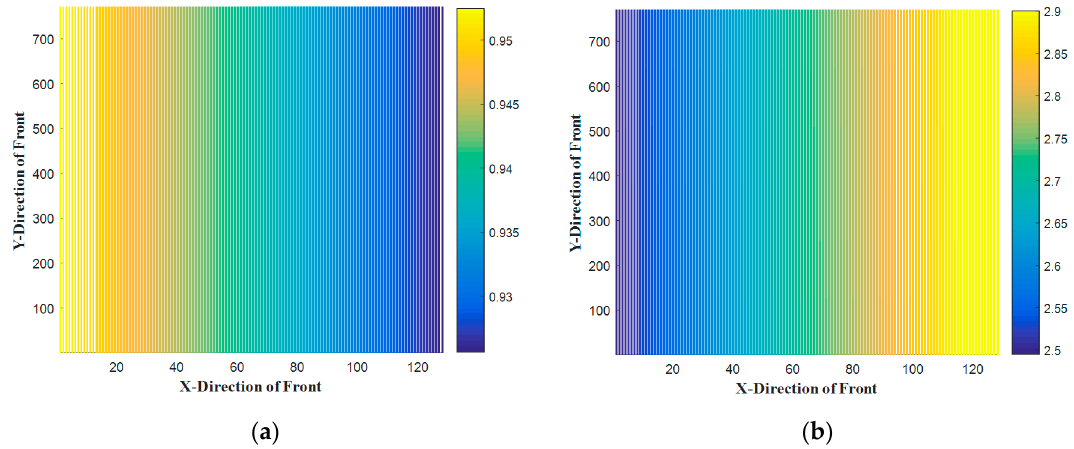
Figure 12. ( a ) Amplitude error; ( b ) phase error under effect of asymmetric temperature